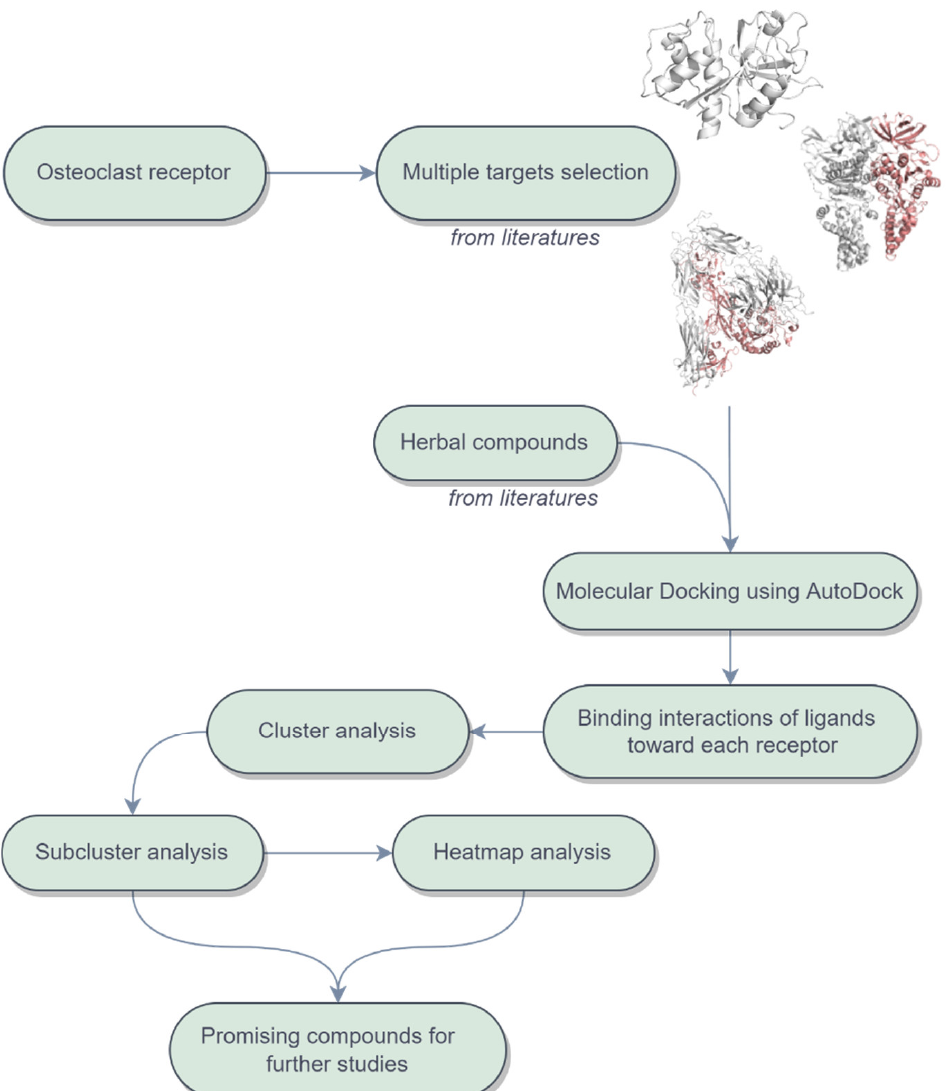
Figure 1. Schematic representation of this study. The potential targets in different osteoclast stages were identified, including Cathepsin K, V-ATPase, and α V β 3 integrin receptor. These targets were investigated to find the interaction with phytochemicals from the previous literature through molecu- lar docking. The docking results were clustered to find the potential cluster based on the AutoDock binding interactions. The compounds in the selected cluster were subclustered using the clustering method incorporated with the heatmap analysis to find the promising compounds for further